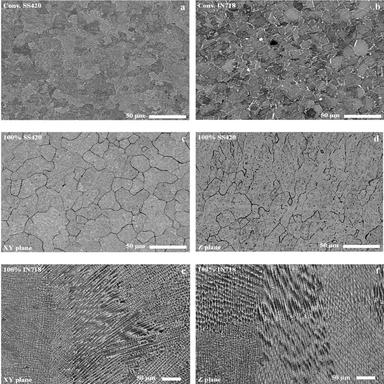
Microstructures of traditionally manufactured and DED fabricated SS420, IN718 a) Conventional 100% SS420, b) Conventional 100% IN718, c) DED 100% SS420 XY plane, d) DED 100% SS420 Z plane, e) DED 100% IN718 XY plane, f) DED 100% IN718 Z plane.